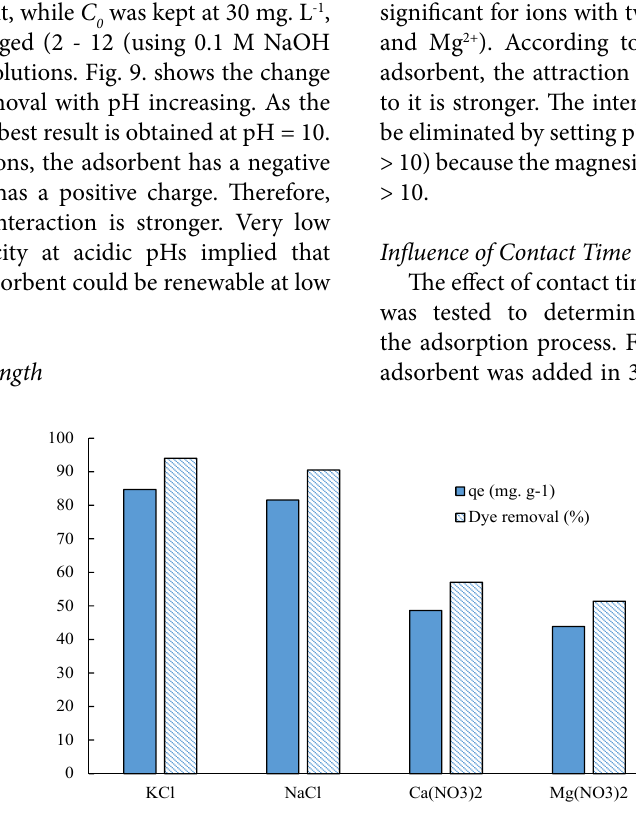
O /C Nanocomposite (C 3 4